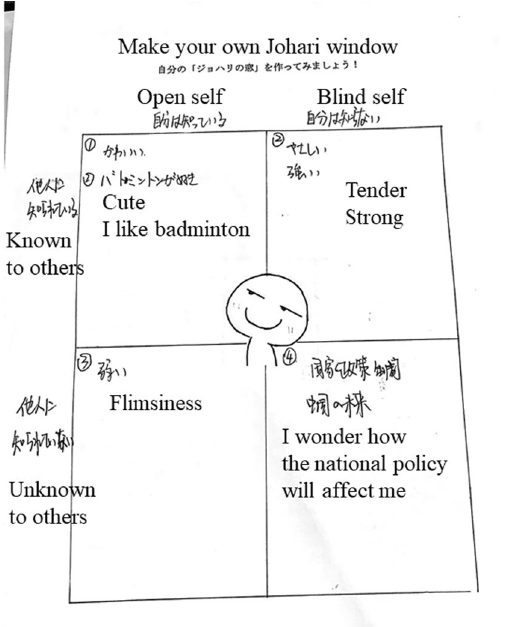
Fig. 2 An example of the worksheet used in Learning Activity